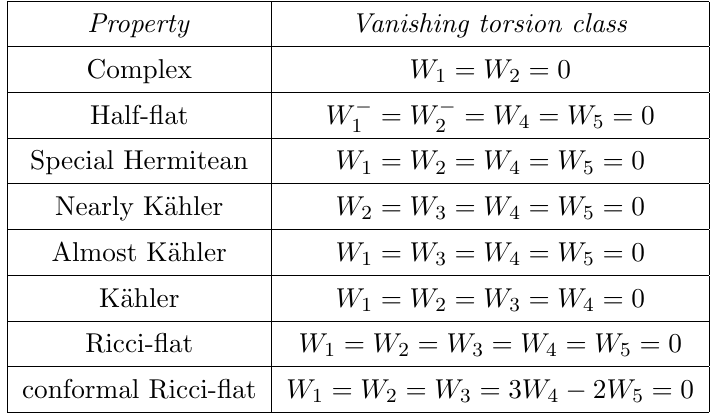
Table 2 . Mathematical properties and associated pattern of torsion classes, taken from ref.